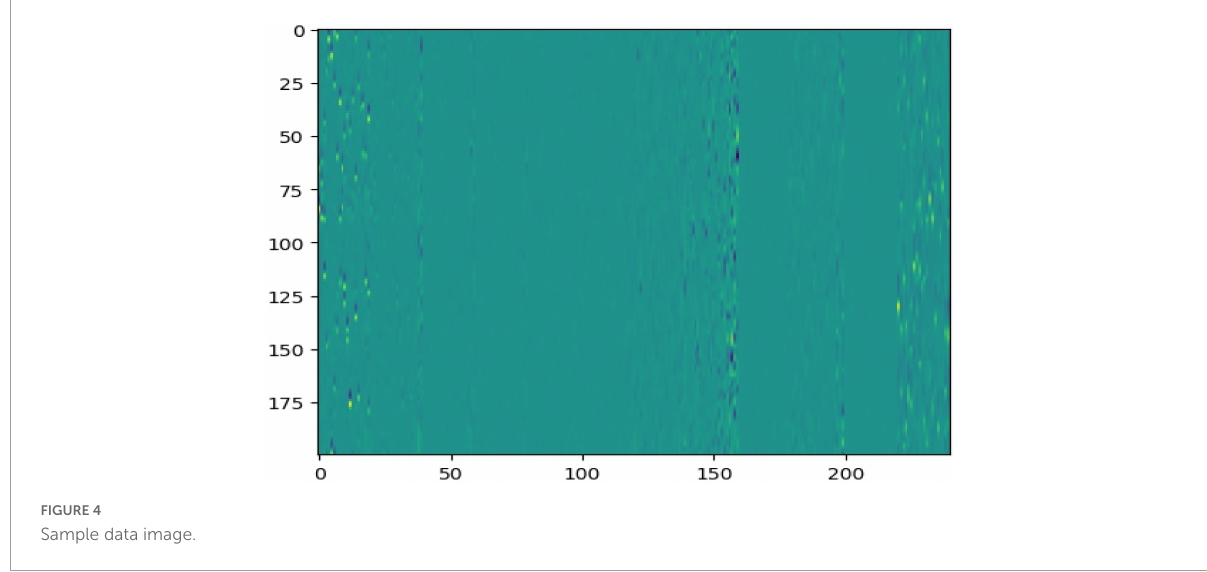
FIGURE4 Sample data image.